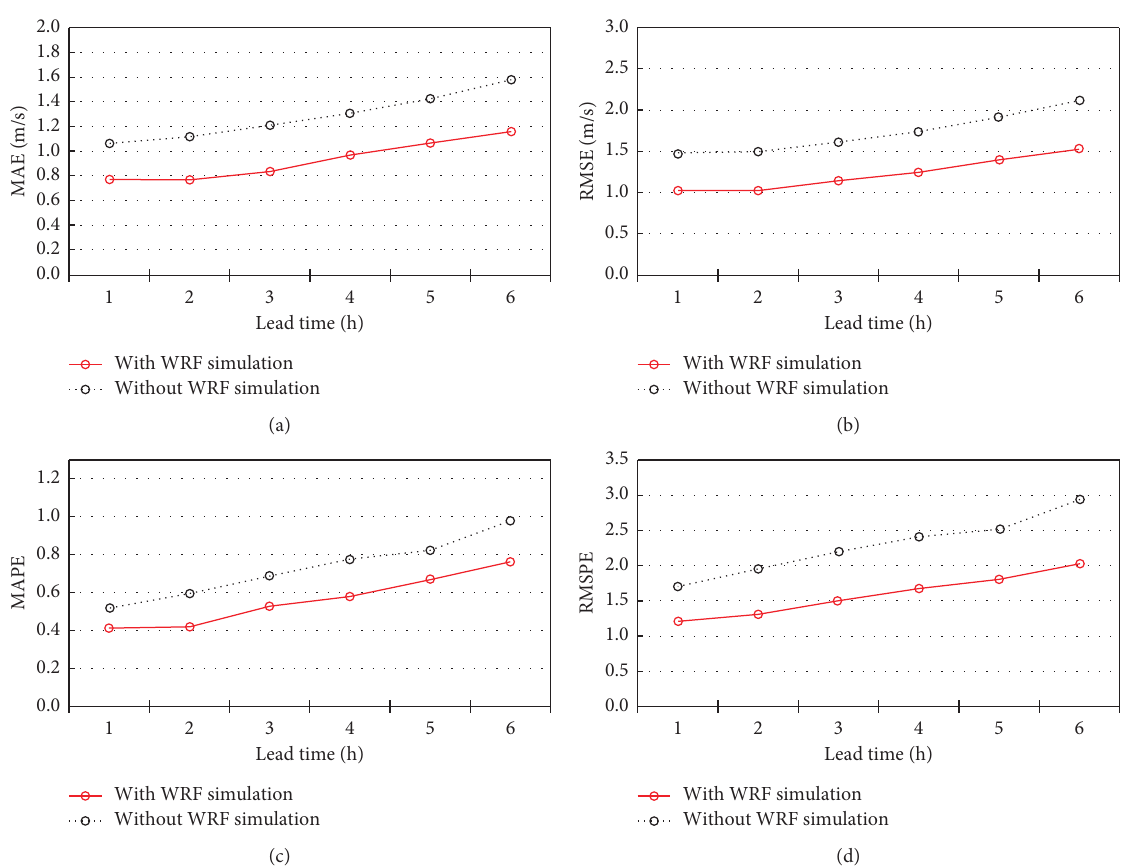
Figure 14: Performance measures of predictive accuracy for the use and nonuse of WRF simulation values on the Taipei gauge: (a) MAE, (b) RMSE, (c) MAPE, and (d) RMSPE.